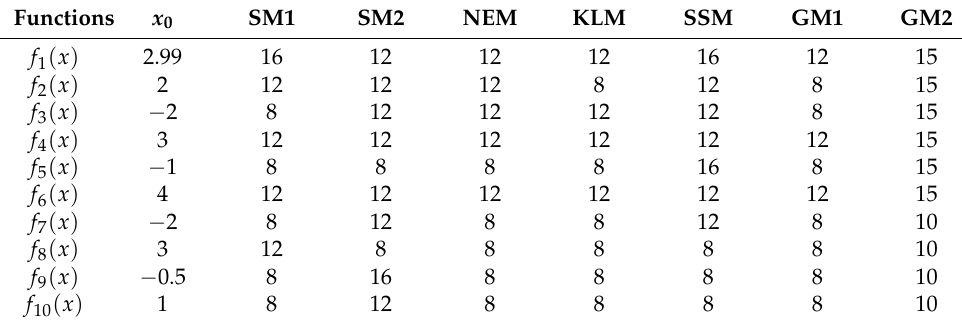
Table 3. Comparison of the number of function